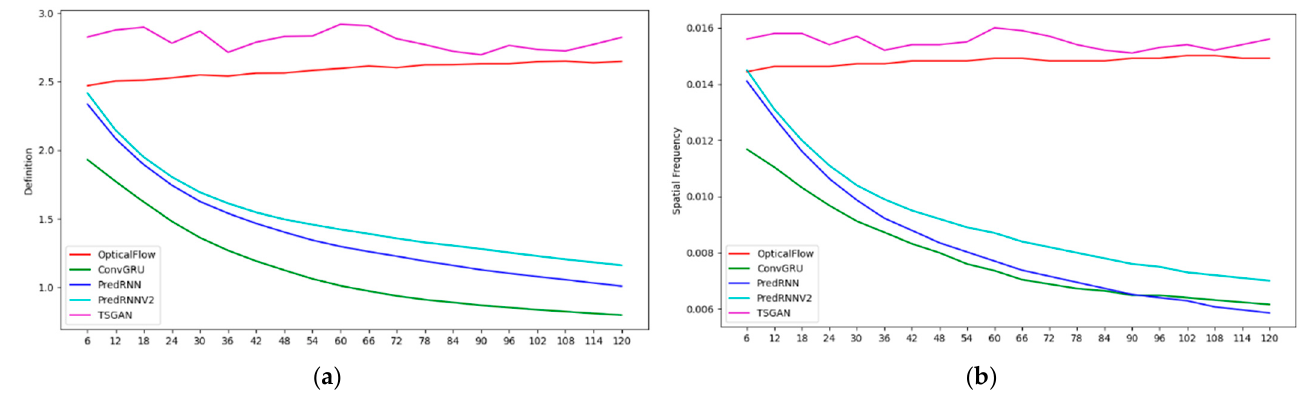
Figure 15. The scores of the spatial details for the forecasts of the typhoon process. (a) Definition; (b) Spatial frequency.